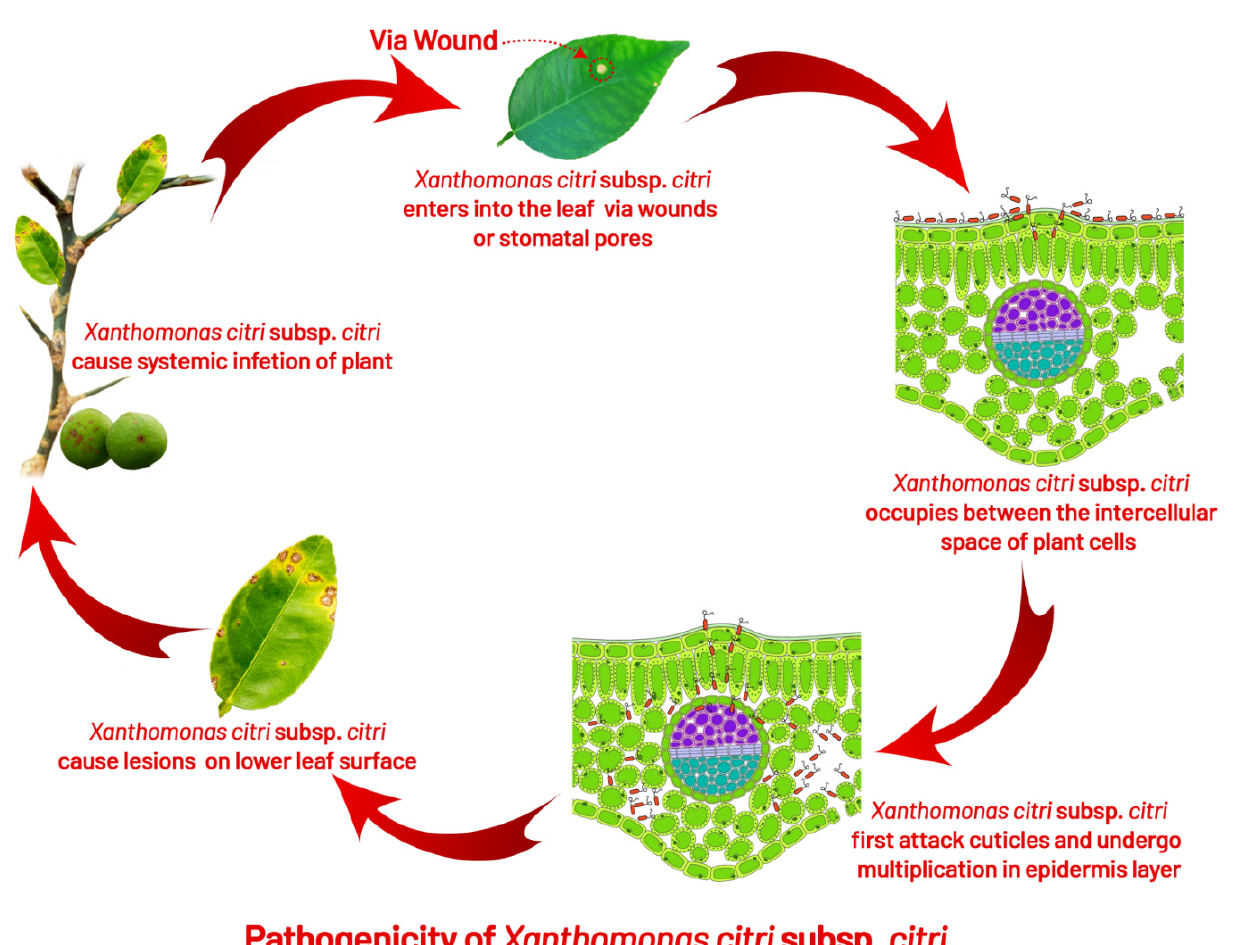
Figure 5. Cellular interaction of Xanthomonas citri subsp. citri with the host and how it expresses symptoms on host plant parts.